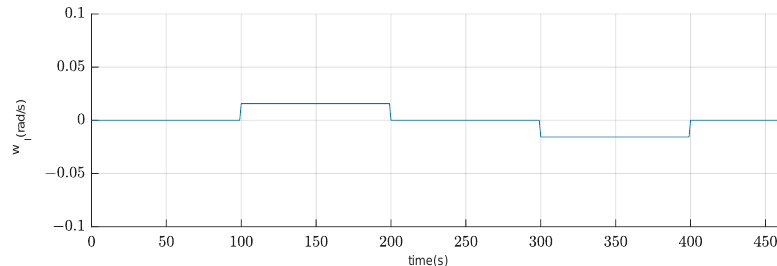
for each follower during the movement. 𝑣𝑣 𝑓𝑓